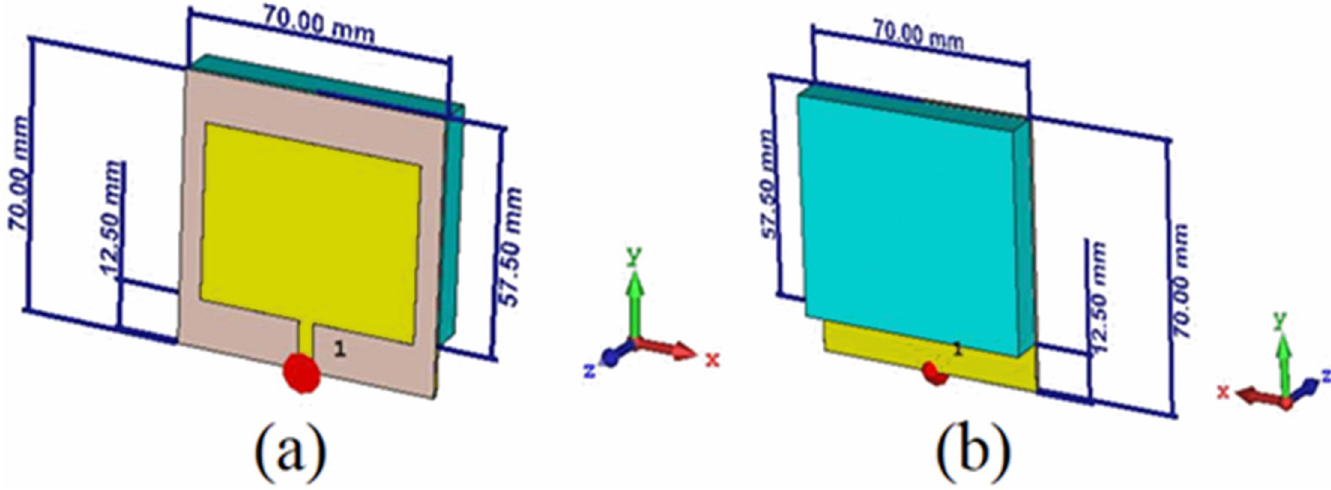
Fig 1. Dimension of the designed PCB rectangular patch antenna: (a) front view and (b) backside view.